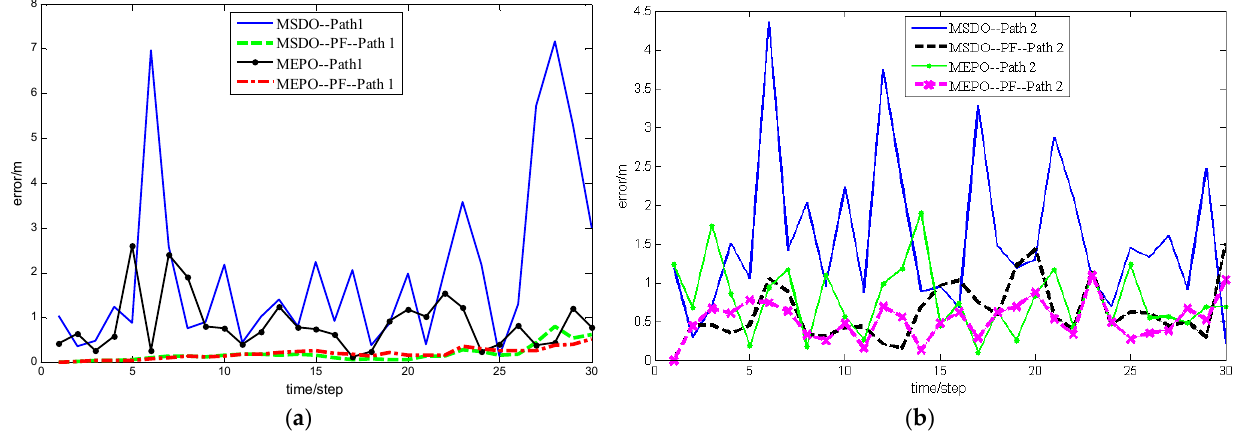
Figure 8. ( a ) Localization error of Path 1 using PF or not ( b ) Localization error of Path 2 using PF or not.